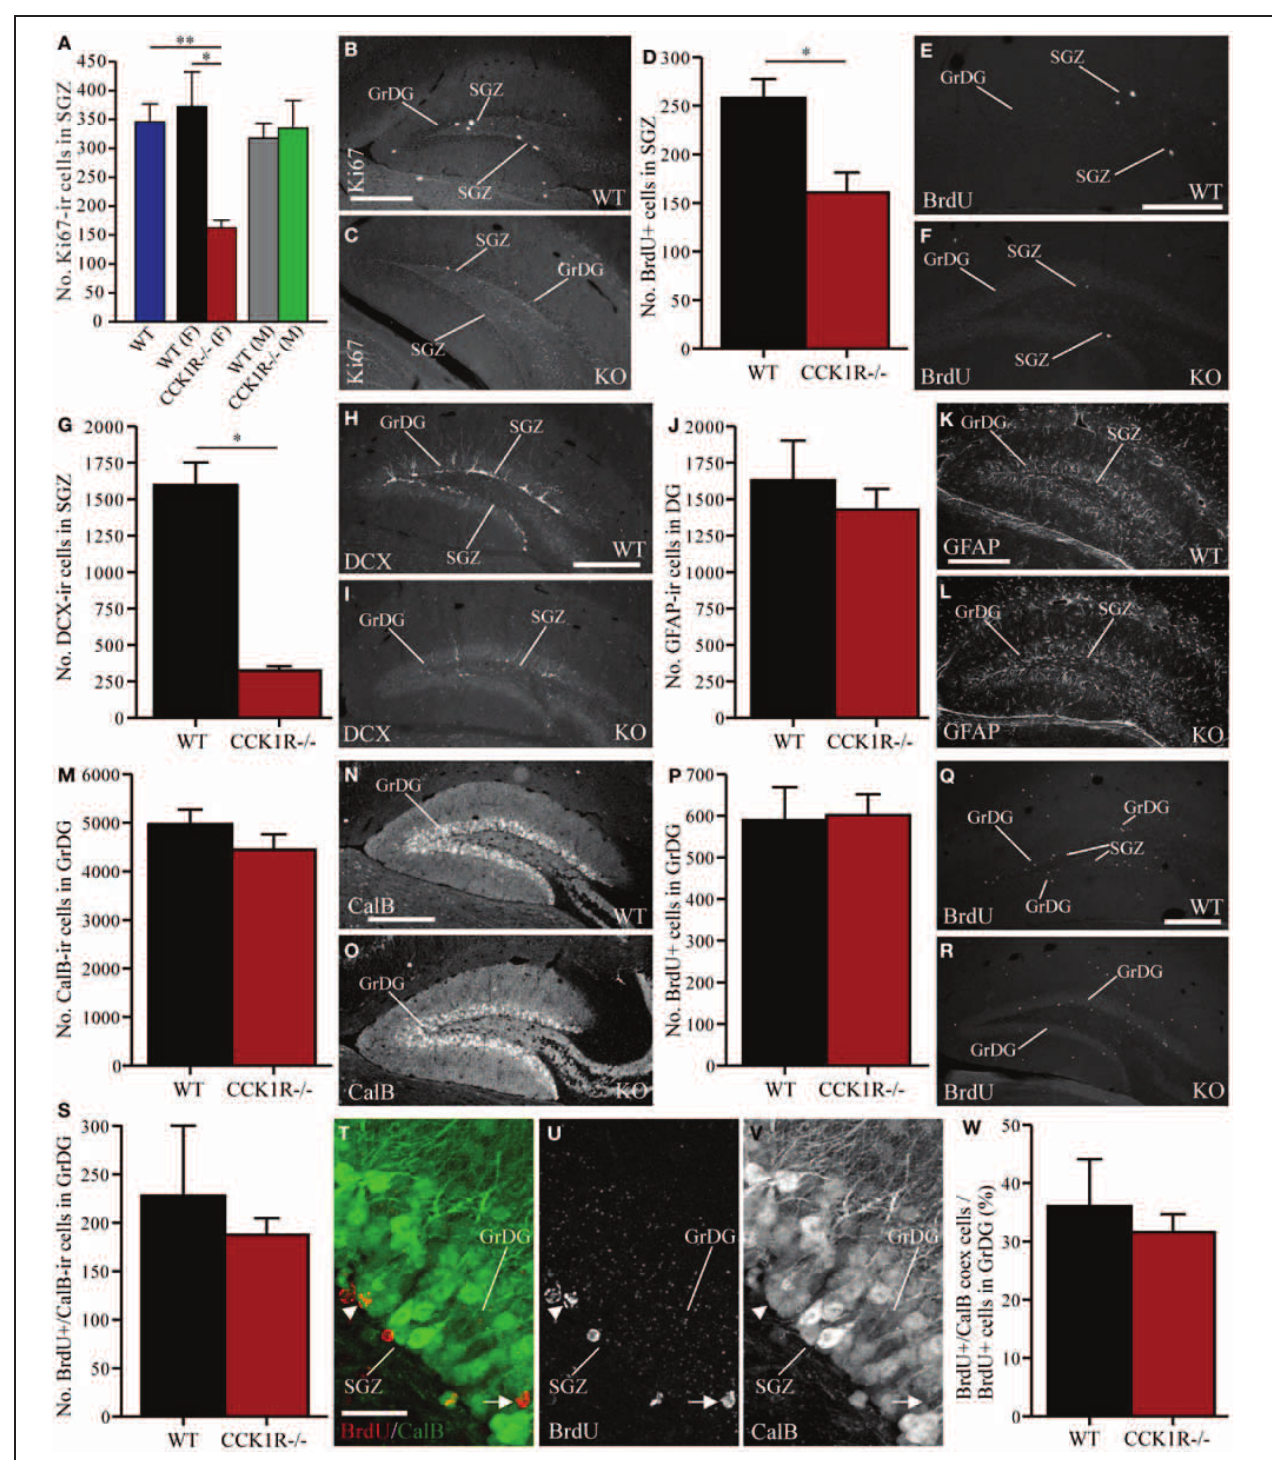
FIGURE 6 | Estimates of proliferating cells, neuroblasts, astrocytes, and mature neurons in the SGZ and GrDG of CCK1R − / − and wild-type mice. (A–C) Estimated number of Ki67-ir cell bodies in the SGZ of CCK1R − / − and wild-type mice (A) . In (A) : WT blue bar = wild-type (male and female combined, n = 8); WT (F) black bar = female wild-type ( n = 4); CCK1R − / − (F) red bar = female CCK1R − / − ( n = 4); WT (M) grey bar = male wild-type